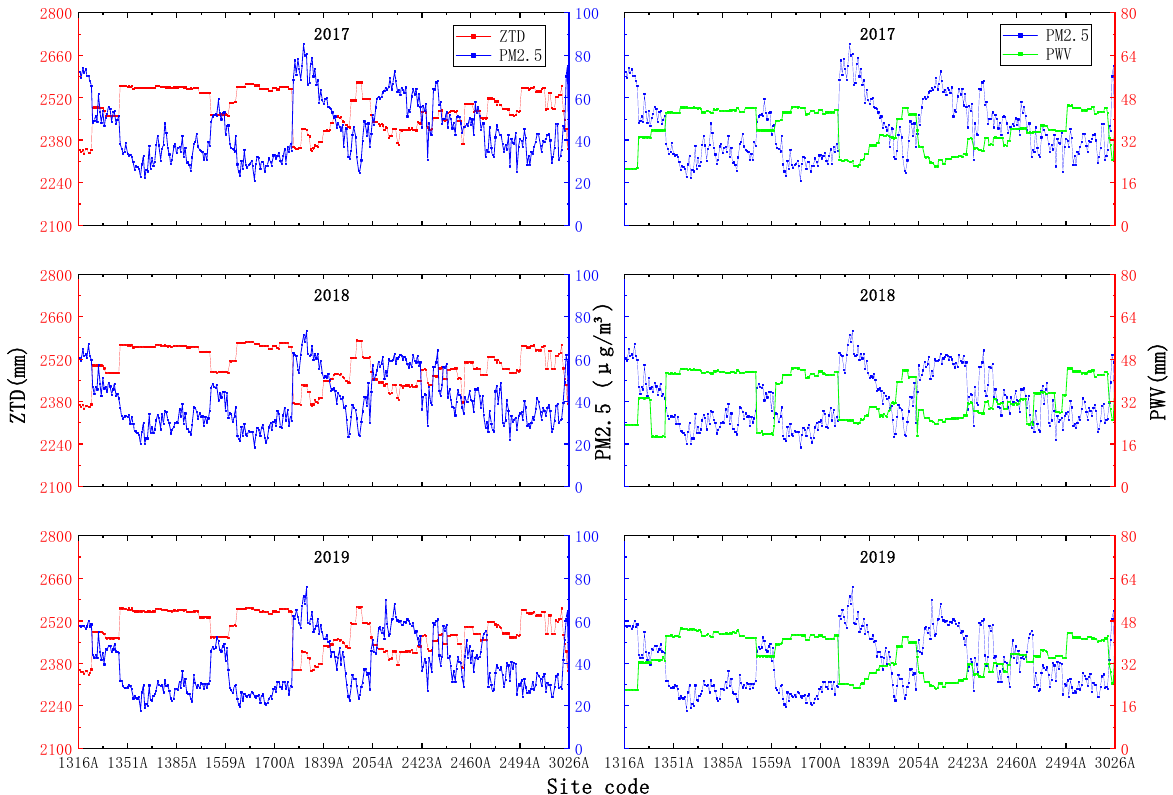
Figure 5. Annual average scale ZTD, PWV and PM 2.5 changes.